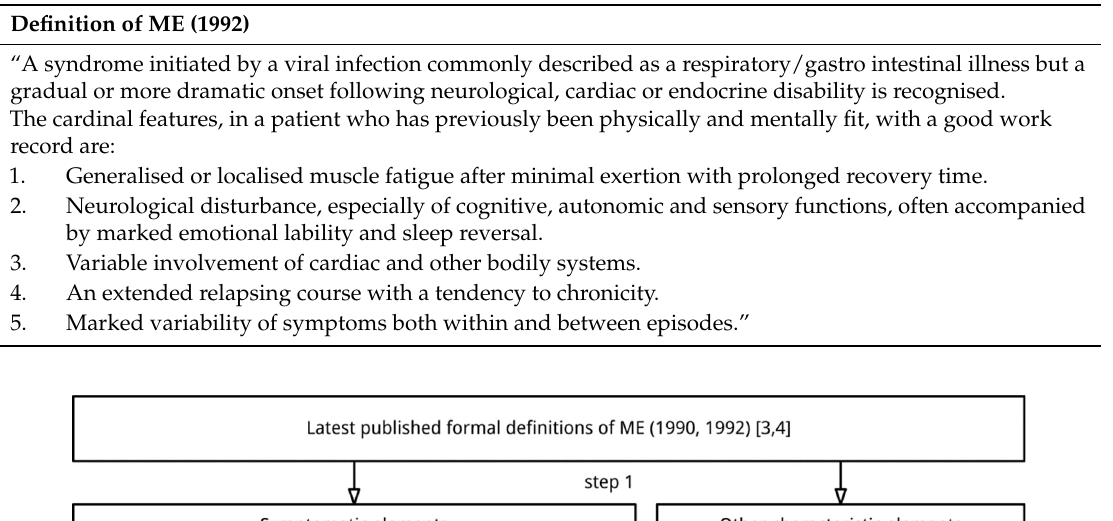
Table 2. The most recent formal definitions of ME (1992) [4].